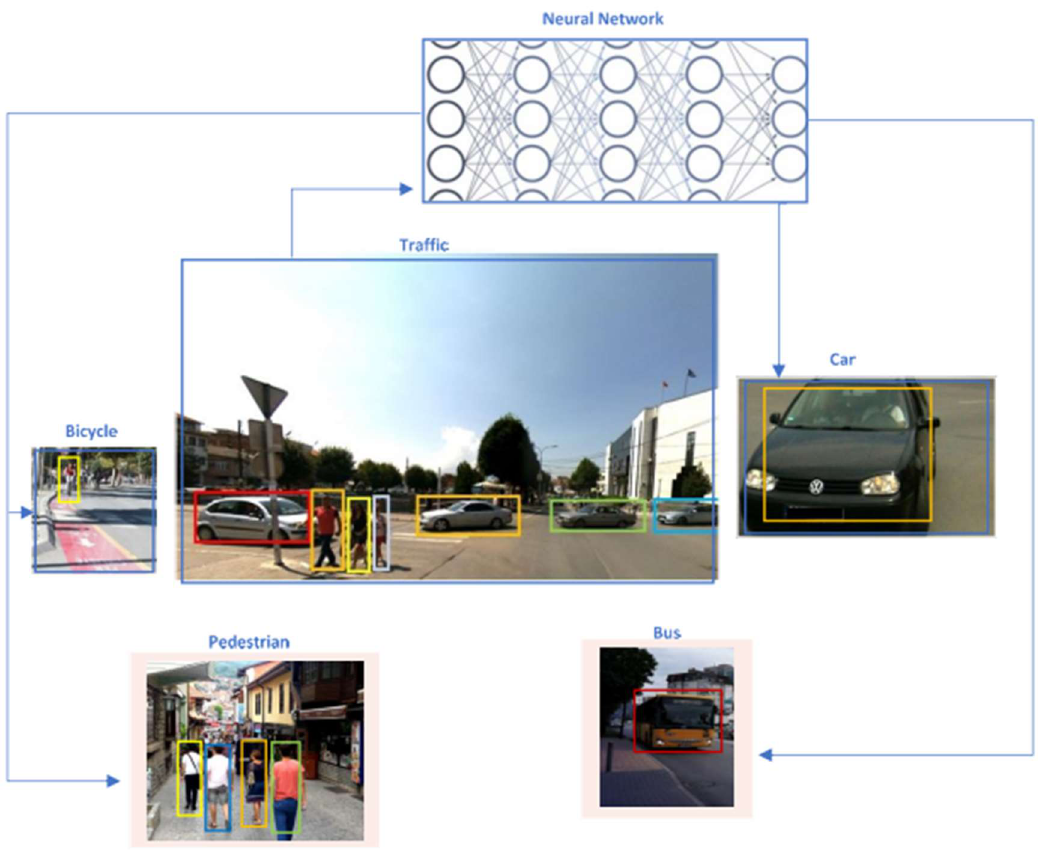
Figure 1. Object detection process of predicting the class of one or more objects within an